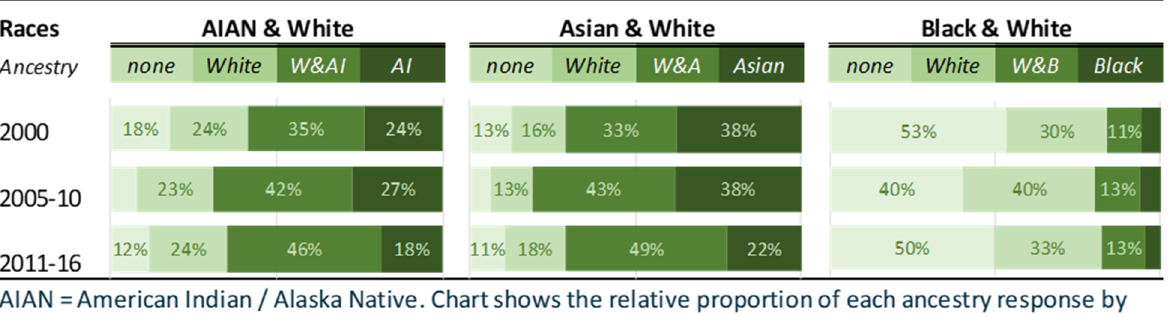
Figure 3. Distribution of ancestry responses in the U.S. among people in three biracial groups, 2000–2016.